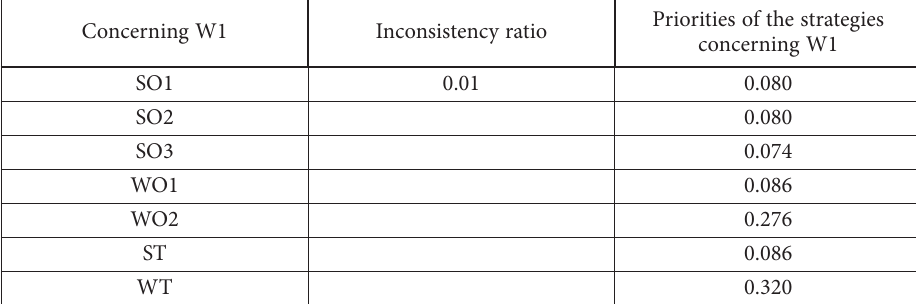
Table 10. Pair-wise comparisons of the strategies in relation to the